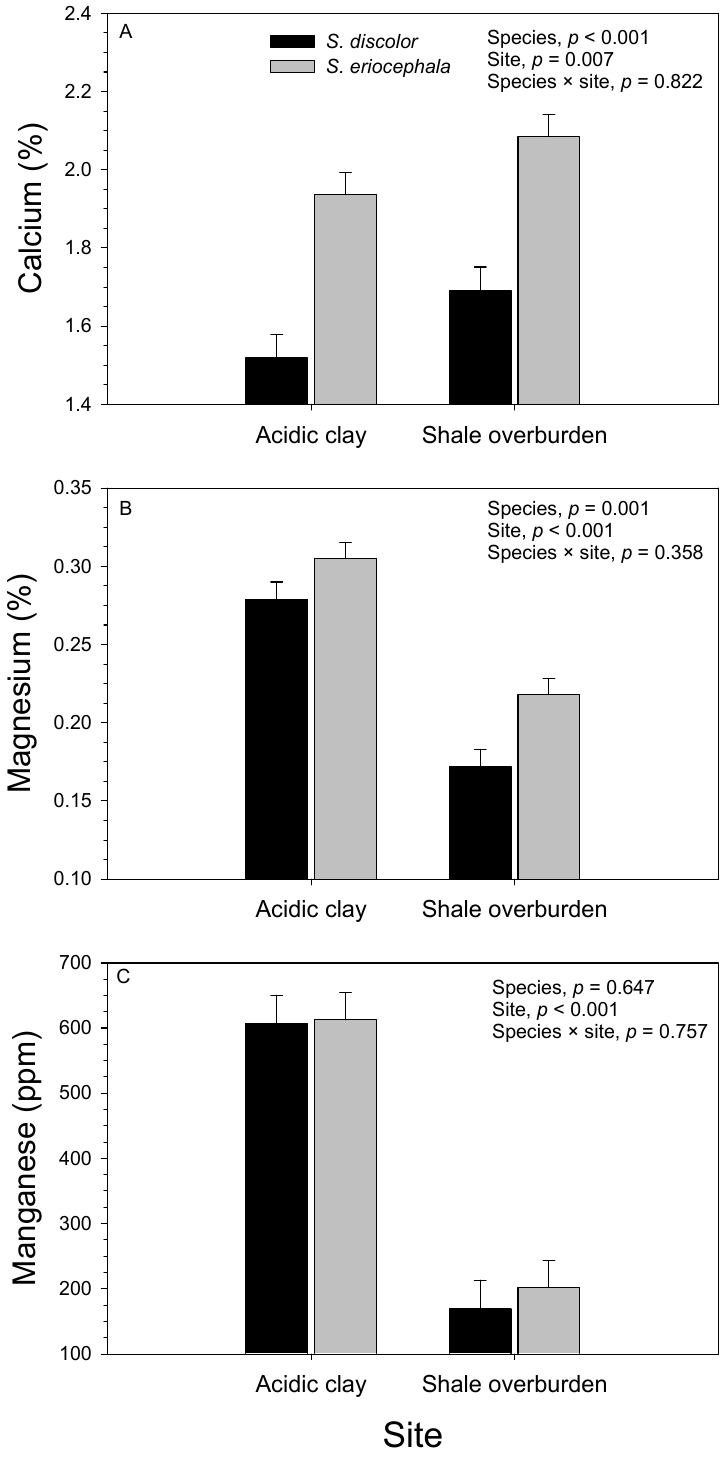
Figure 4. Foliar ( a ) calcium, ( b ) magnesium, and ( c ) manganese concentrations (mean ± SE) of Salix discolor and S. eriocephala on acidic clay and shale overburden sites.